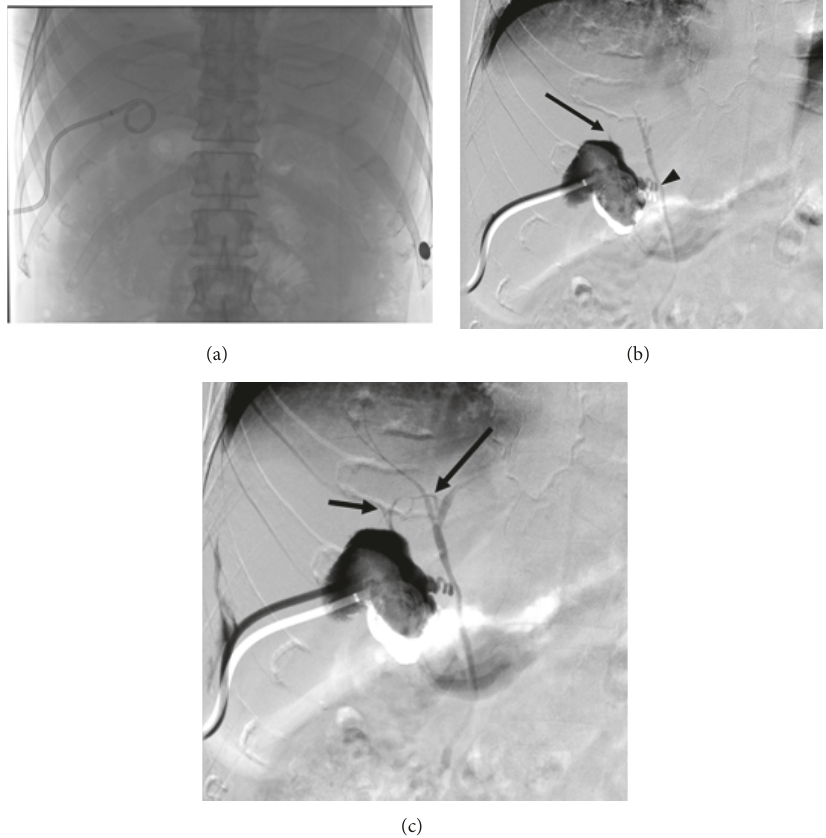
Figure 2: (a) Frontal fluoroscopic scout image of the PCT. (b, c) Digital subtraction cholecystography (cholecystogram). (b) Filling of the gallbladder via contrast injection through the PCT demonstrates early filling of the gallbladder as well as the common bile duct (CBD) and CHD via the CD (arrowhead). An additional duct is seen extending superiorly from the gallbladder (arrow). (c) The accessory duct eventually communicates with the right posterior duct (RPD) (long arrow). Contrast also refluxes into a smaller segmental duct extending from segment VII (short arrow) and feeds into the accessory cholecystohepatic duct.